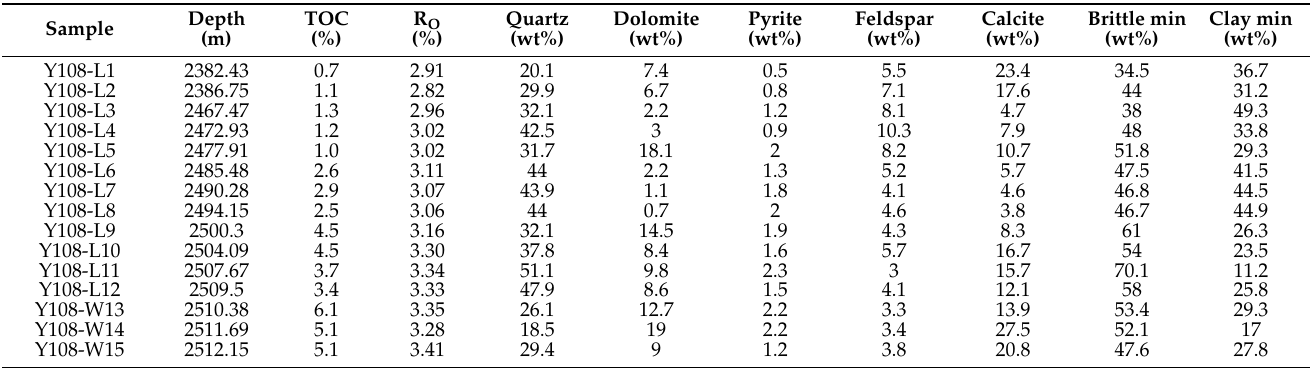
Table 1. TOC content and mineralogical composition of Wufeng–Longmaxi shale